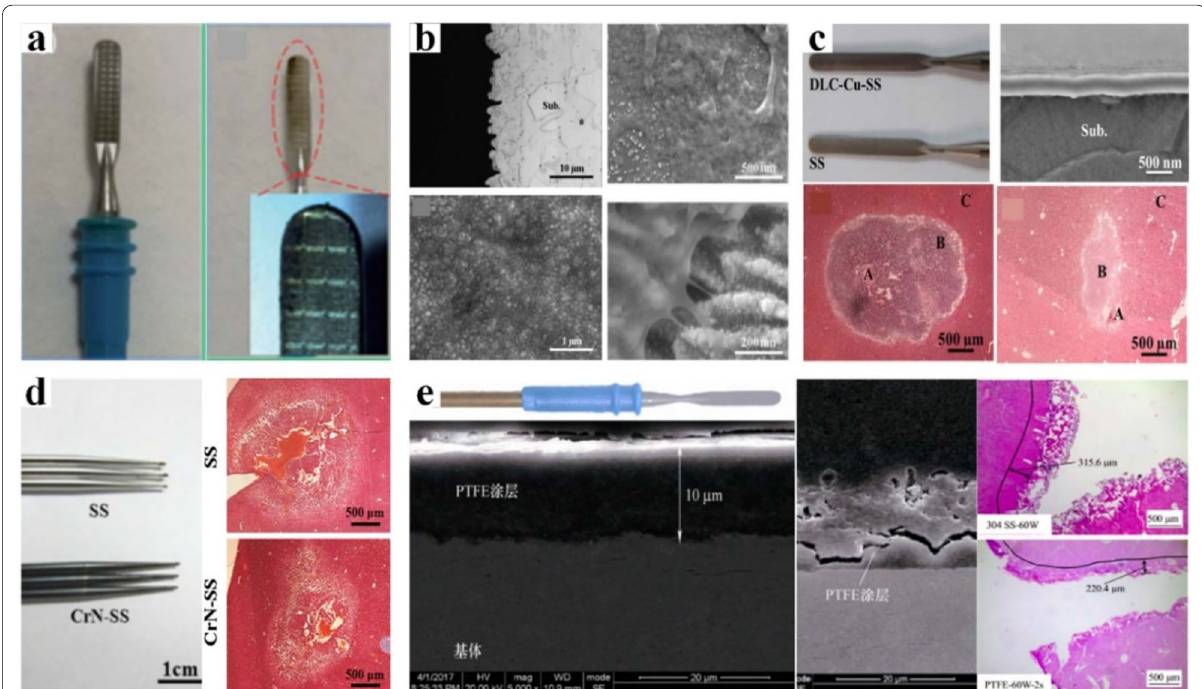
Figure 5 Dry anti-adhesion strategies for surgical scalpels: ( a ) maize-leaf-inspired grid-like hydrophobicity surface, ( b ) femtosecond laser pulse modification micro-nanostructured surface, ( c ) DLC-Cu coated anti-adhesion surface, ( d ) CrN coated anti-adhesion surface, and ( e ) PTFE-coated anti-adhesion